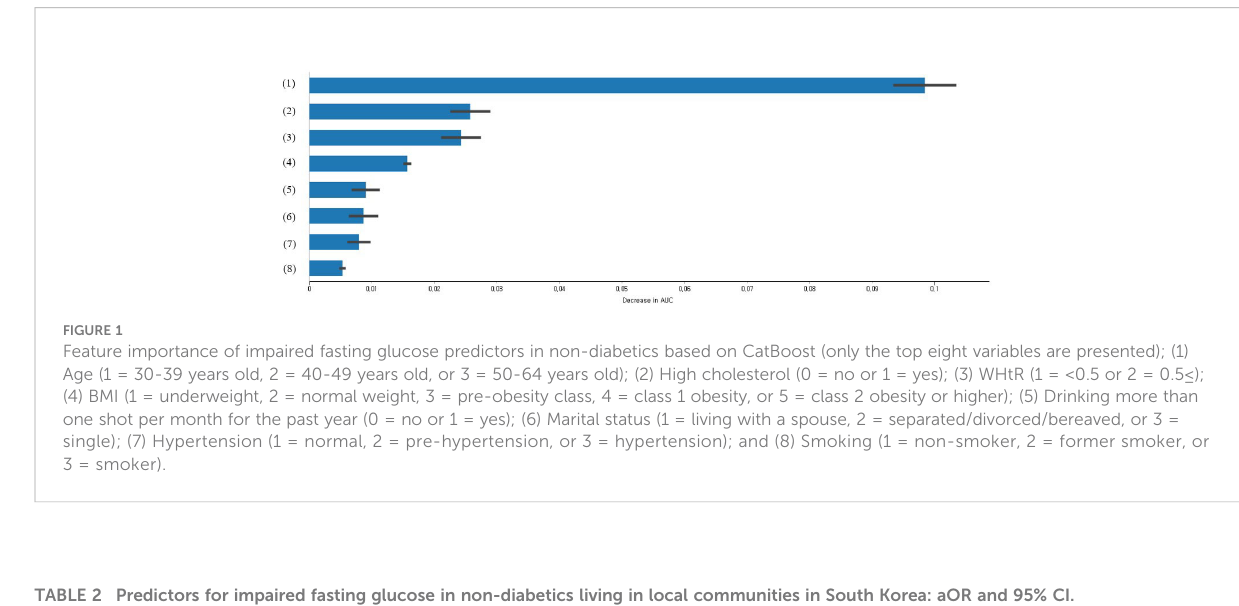
TABLE 2 Predictors for impaired fasting glucose in non-diabetics living in local communities in South Korea: aOR and 95% CI. Variables aOR 95% CI